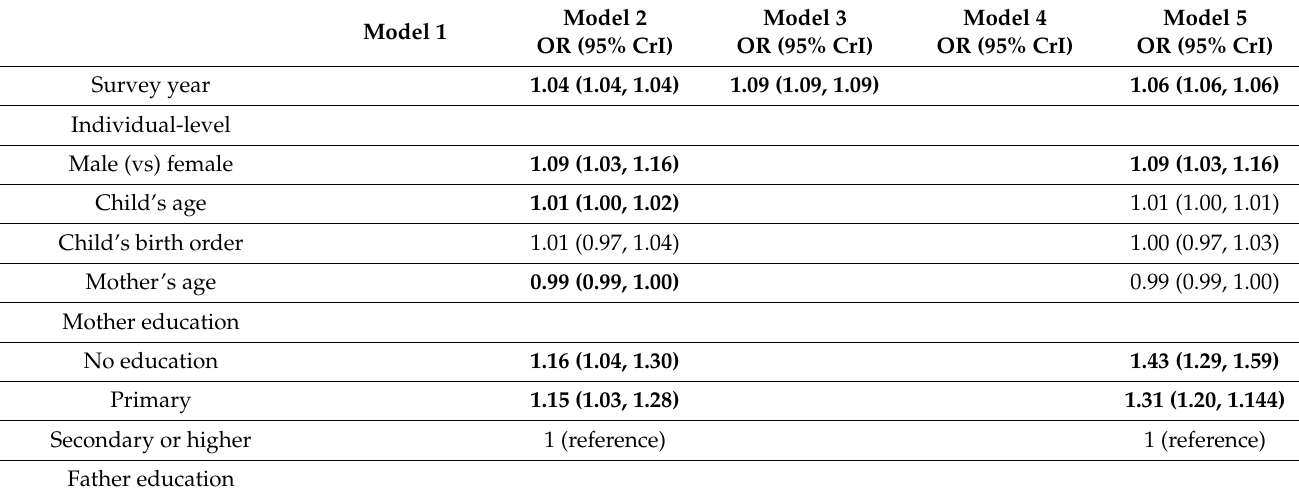
Table 2. Individual compositional and contextual factors associated with non-vaccination for polio identified by multivari- able multilevel logistic regression models, Demographic and Health Surveys data,